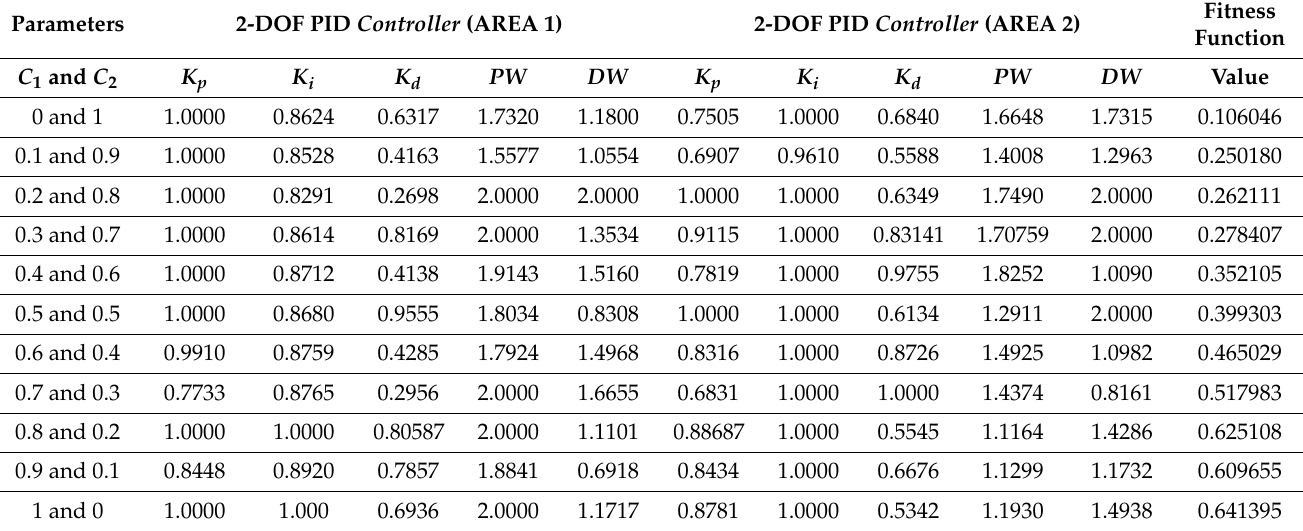
Table 5. System efforts using DA-FOPID controller via the proposed IB-WGFF.